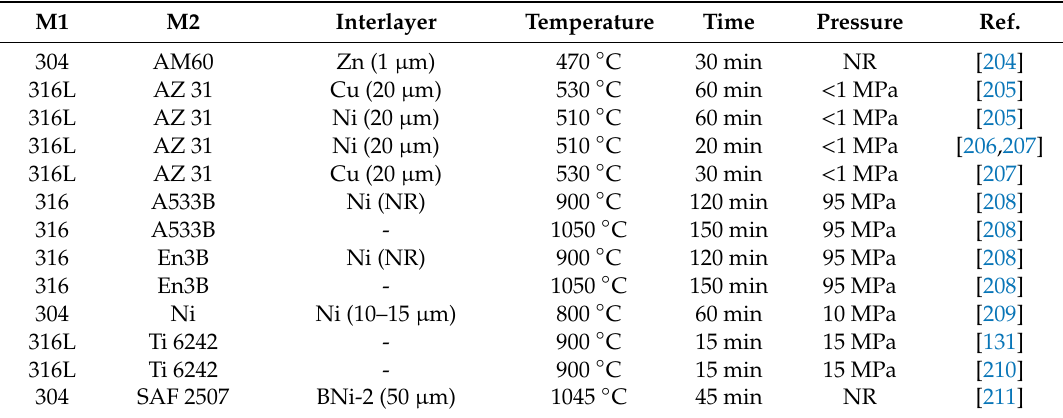
Table 9. Reported parameters for di ff usion bonding and TLP bonding of 304 and 316 to various other materials not discussed